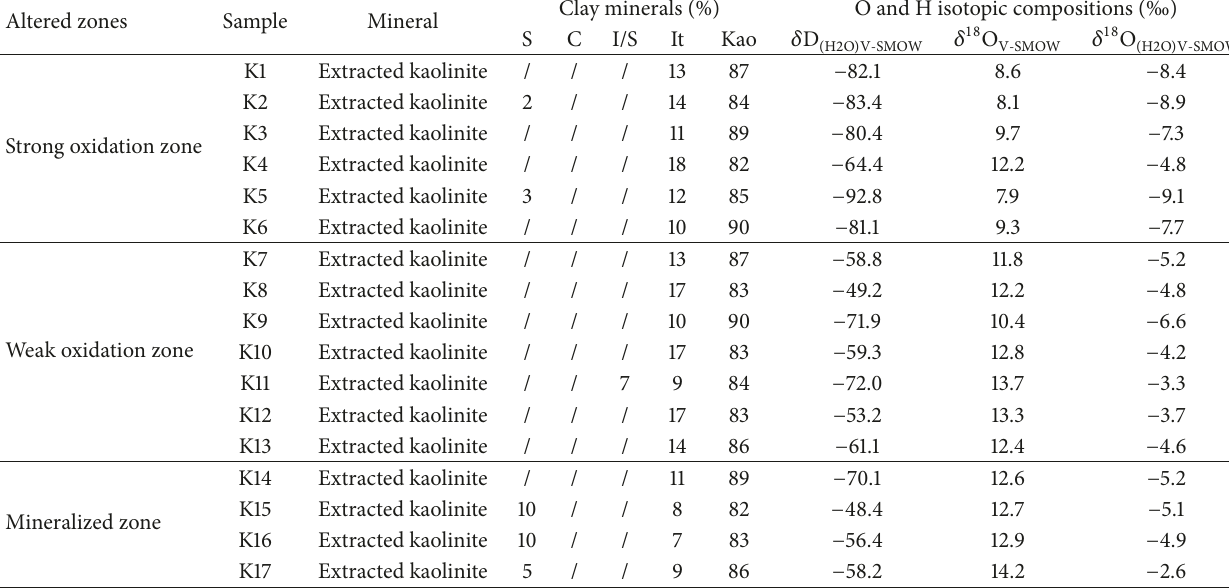
Table 5: O and H isotopic compositions of extracted kaolinite from altered zones in the Mengqiguer uranium deposit. Altered zones Sample